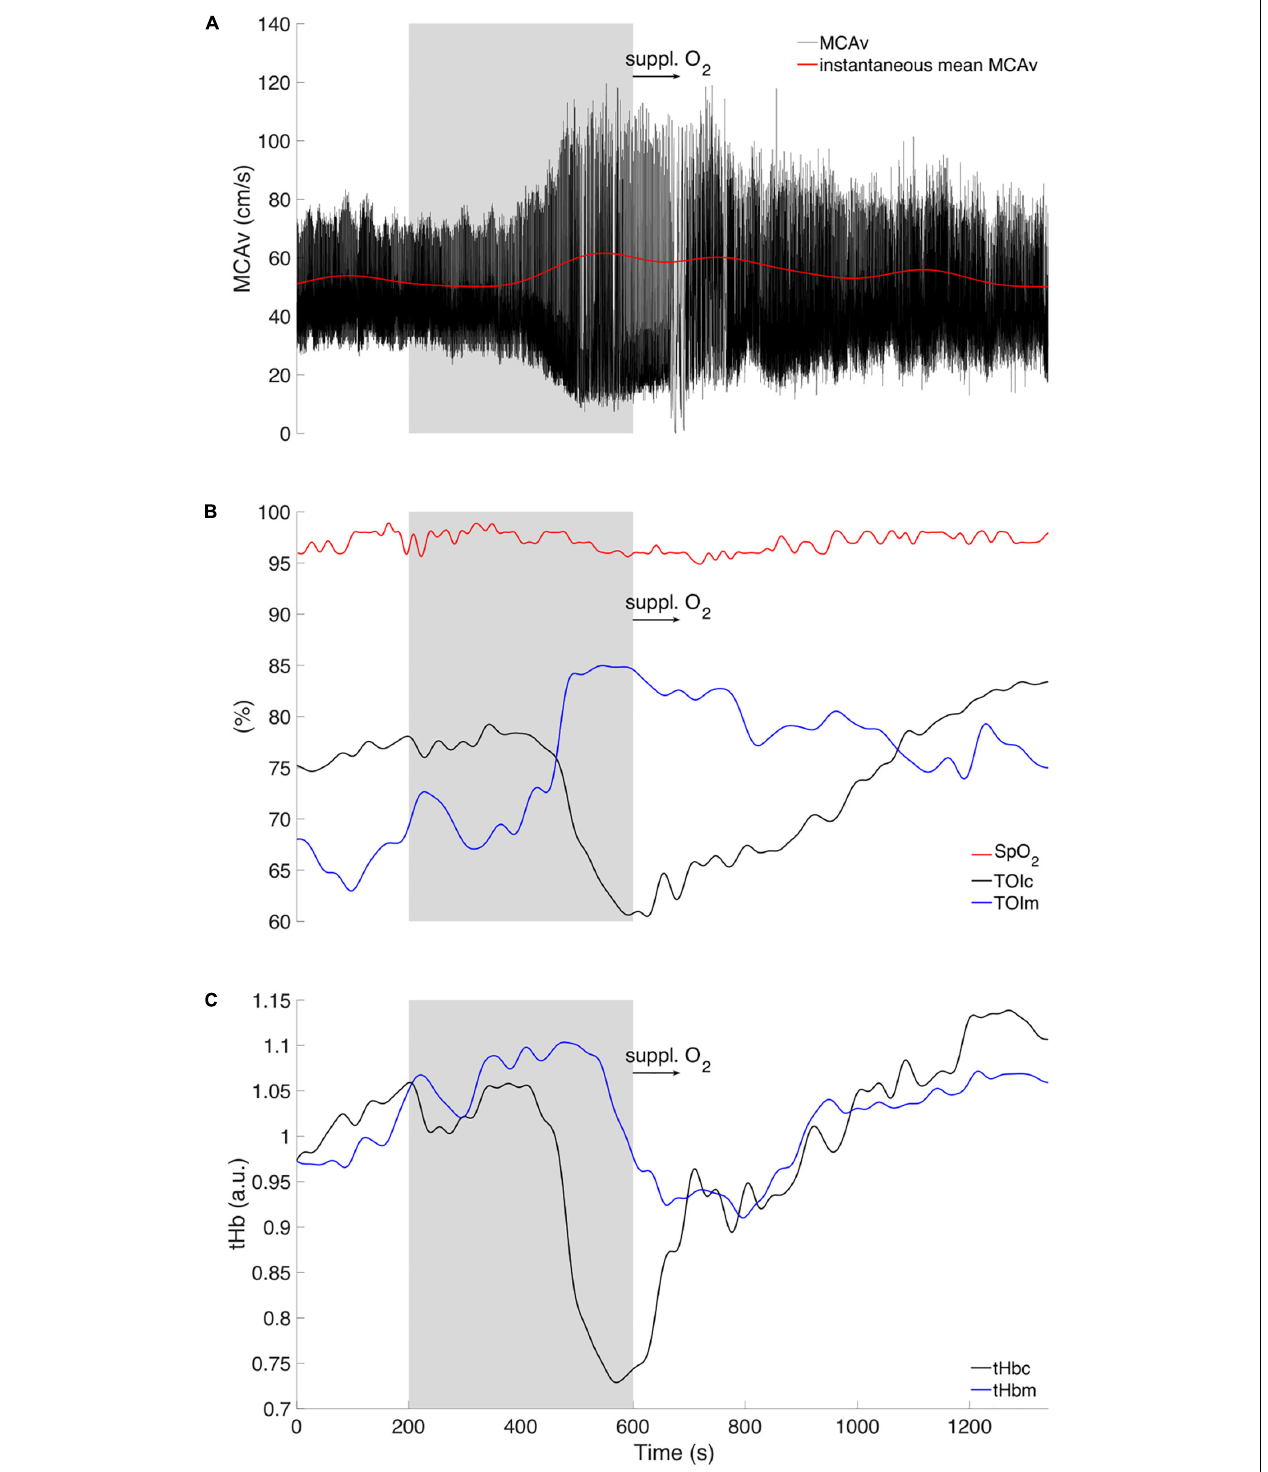
FIGURE 2 | Original tracing of instantaneous (A) middle cerebral artery velocity (MCAv, black trace) and mean value (red trace). (B) Pulse oxygen saturation (SpO 2 ) (red trace). Hemodynamic responses of cerebral tissue (TOI c ) and muscular (TOI m ) oxygenation index in black and blue tracings, respectively. (C) Tracings represent cerebral (tHb c , black trace) and muscular (tHb m , blue trace) total hemoglobin relative concentrations. Displayed for three phases: Baseline (0–200 s), vasovagal reaction (gray area, 200–600 s), and recovery period (600–1200 s) with brief 100% medical oxygen administration (black arrow, 600–700 s).